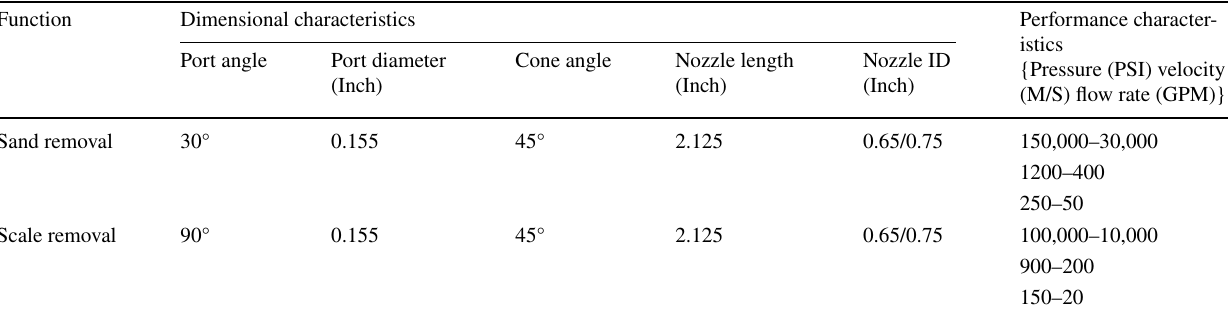
Table 10 Selection of nozzle for sand and scale removal